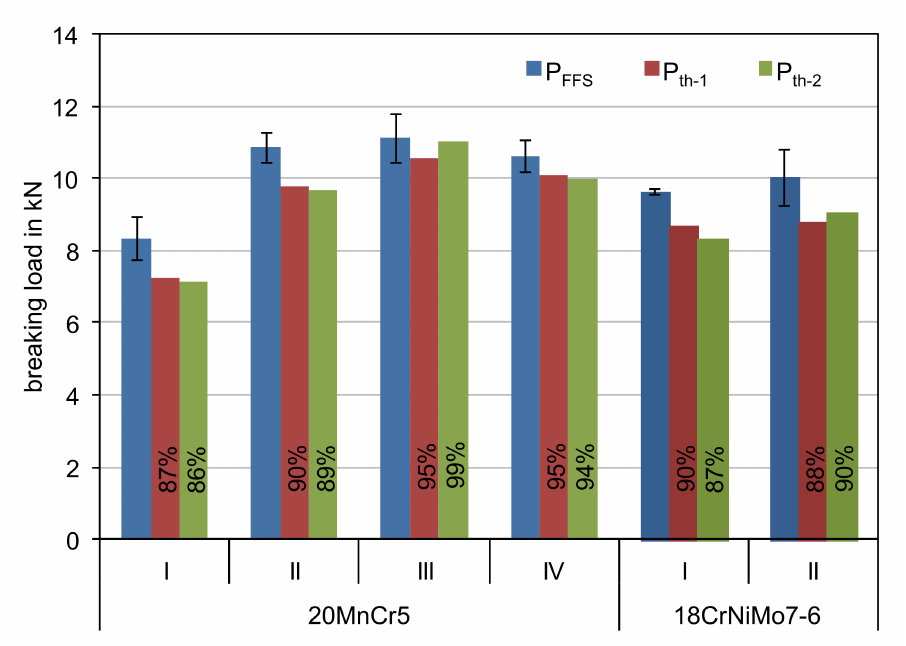
Figure 14. Result of the incremental step loading test of the different materials, fast fracture load P FFS (x ± s, n = 3), threshold loads P th-1 and P th-2 (x, n = 3).